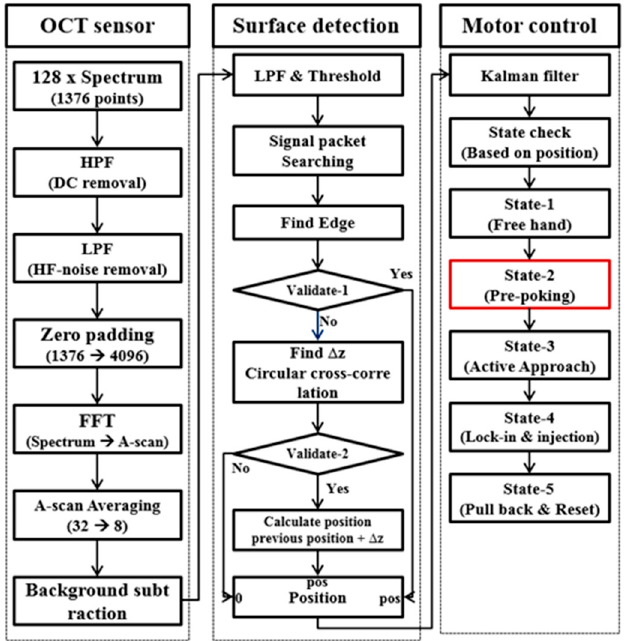
Figure 3. Flowchart of OCT data processing for distal sensing and motion control. The processing consists of three main parts: (1) OCT data transformation from measured spectral data, (2) distal information extraction from the OCT data, and (3) motion control based on the distal information. HPF: high-pass filter, LPF: low-pass filter, and FFT: Fast Fourier Transformation. Appl. Sci. 2018 , 8 , x FOR PEER REVIEW